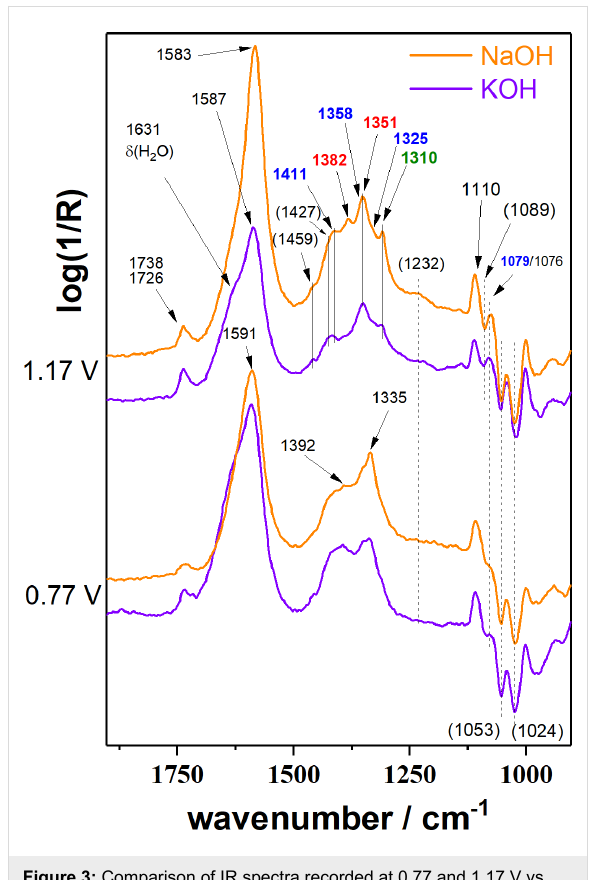
Figure 3: Comparison of IR spectra recorded at 0.77 and 1.17 V vs RHE (further potentials are shown in Supporting Information File 1, Figure S2) for Pd/NCNT after electrooxidation of 1 M glycerol for 14.7 min in 0.1 M of NaOH or KOH, respectively ( d TL = 28